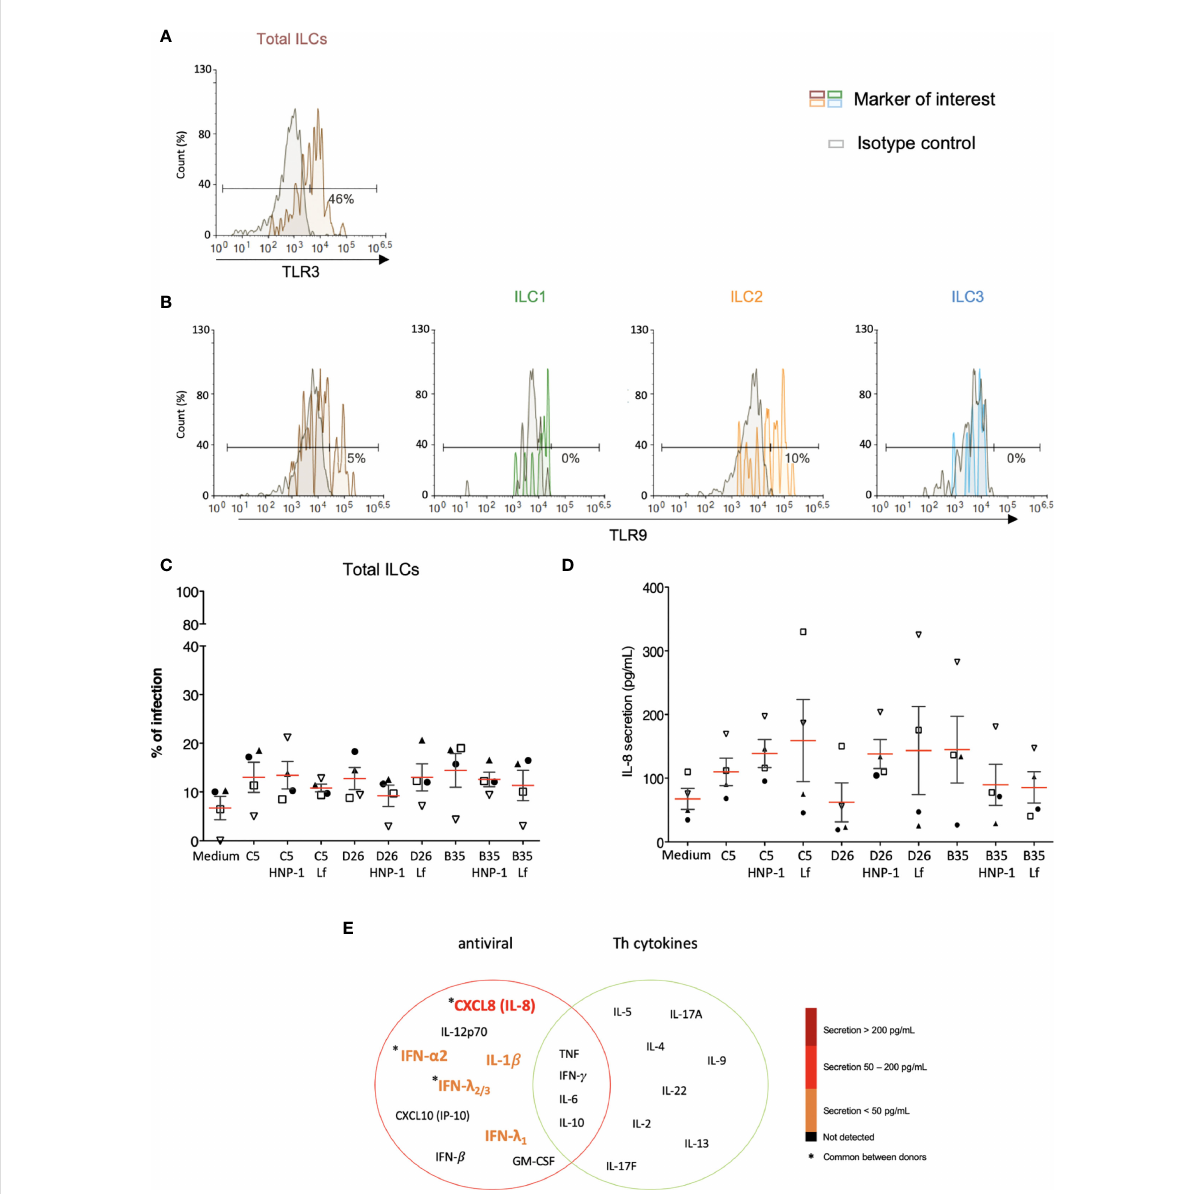
FIGURE 7 PRR expression and impact of HDPs on uptake and cytokine pro fi le. The levels of (A) TLR3 by ILCs; and (B) TLR9 by total ILCs, ILC1, ILC2, and ILC3. Cell populations were normalised to 100%. Results are representative of 2 - 5 donors. (C) ILC uptake of HAdVs complexed with HNP-1 or lactoferrin: GFP expression by ILCs was quanti fi ed 24 h post-challenge with each HAdV ± HDP (HNP-1 or lactoferrin) for total ILCs (n = 4). (D) Cytokines release in the presence of HNP-1 or lactoferrin: cytokines belonging to an antiviral panel and a Th cytokine panel in the supernatant of HAdV-infected ILCs was quanti fi ed using CBA (n = 4). Cytokine levels are denoted by the colour code and the results were analyzed with the LegendPlex ™ software. Only the cytokines whose secretion level was at least 2-fold higher than that of the controls are presented. (E)